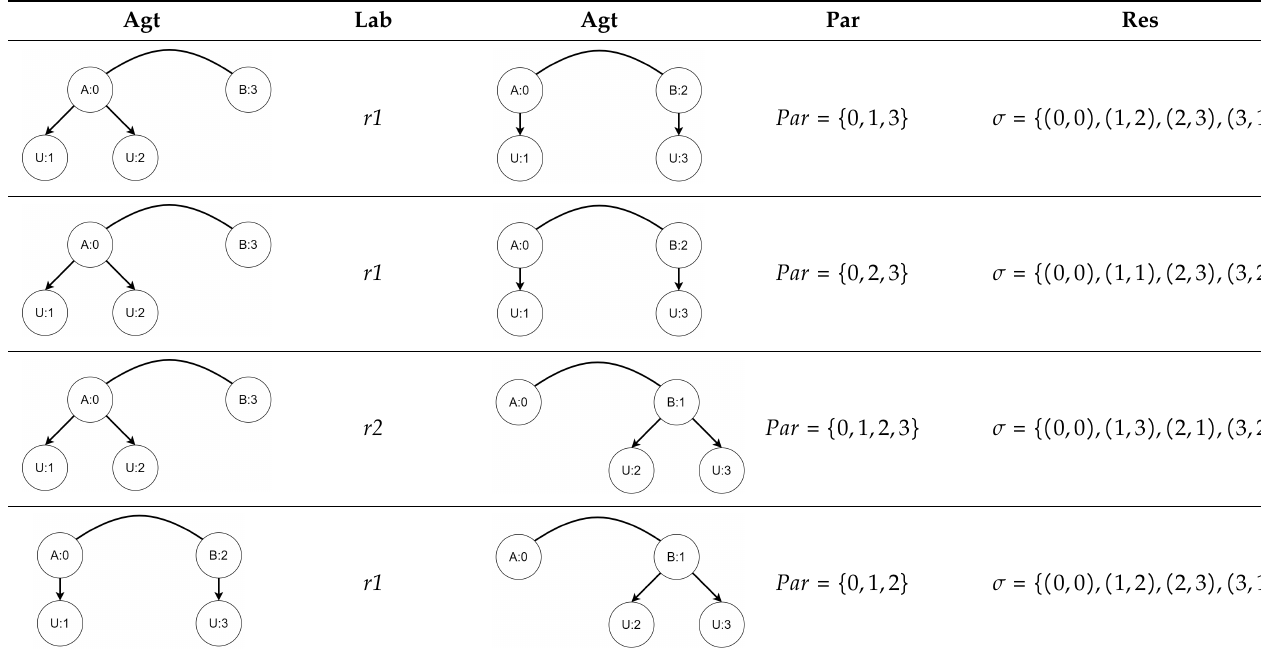
Table 1. An example of a Tracking Transition System. Each row defines a single transition in the system. The initial state is defined in the first column of the first row. The definition of two reaction rules used to generate this TTS were omitted but they allow to move either one or two nodes of type U from A to B at once.